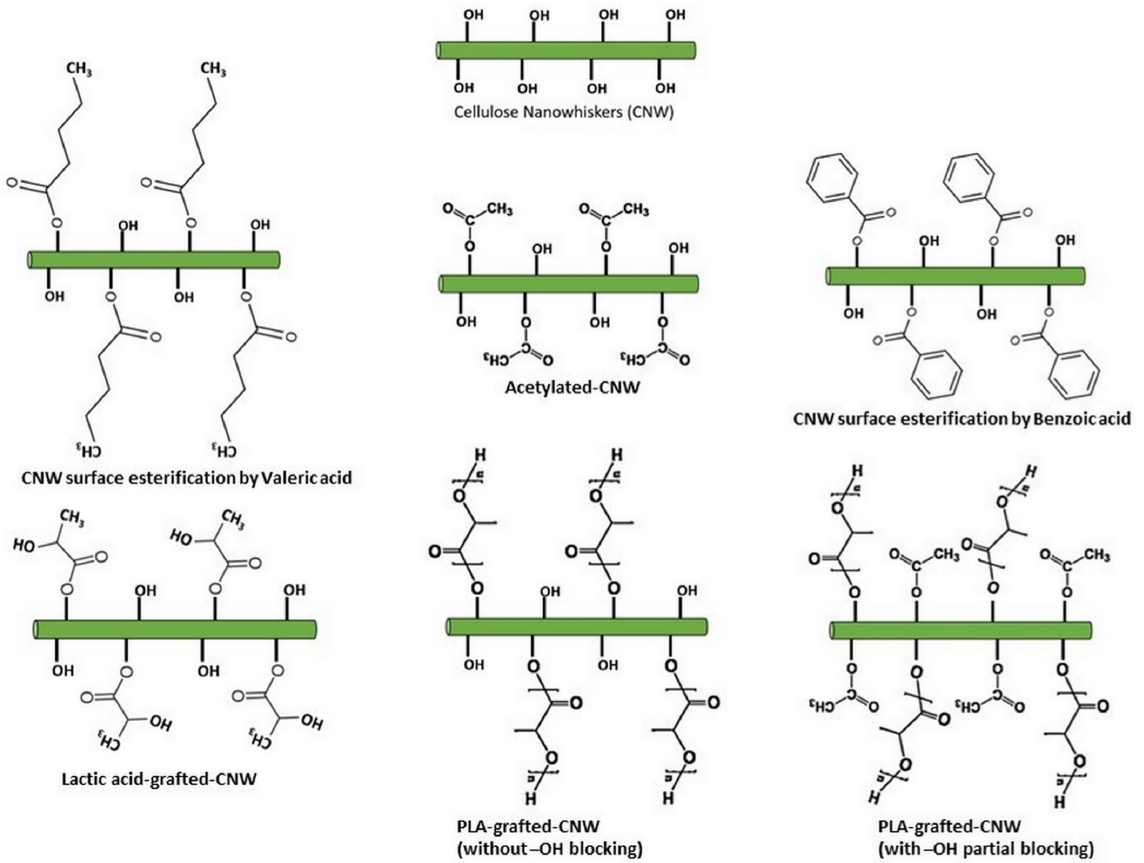
Figure 3. Illustration of surface modifications of CNW particles.